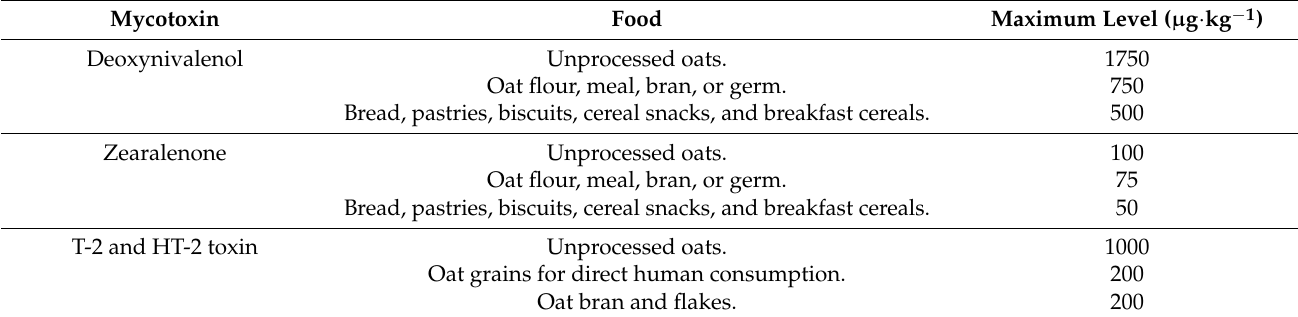
Table 1. Maximum EU limits for deoxynivalenol, zearalenone, and the sum of T2 and HT-2 toxins in unprocessed cereals and finished products intended for human consumption. For T-2 and HT-2 toxins, no limit values are defined, but only indicative values. Mycotoxin Unprocessed